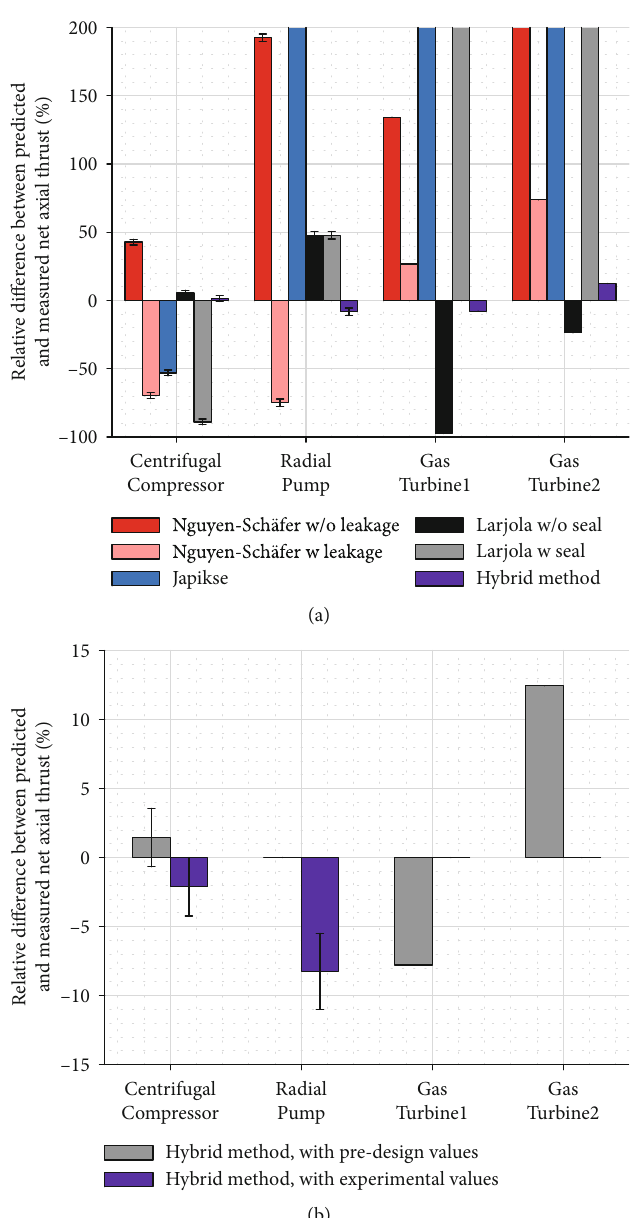
Figure 13: (a) The axial thrust predicted with three previously published methods and the new hybrid method. (b) The axial thrust predicted with the new hybrid method when using the predesign and experimental values as input